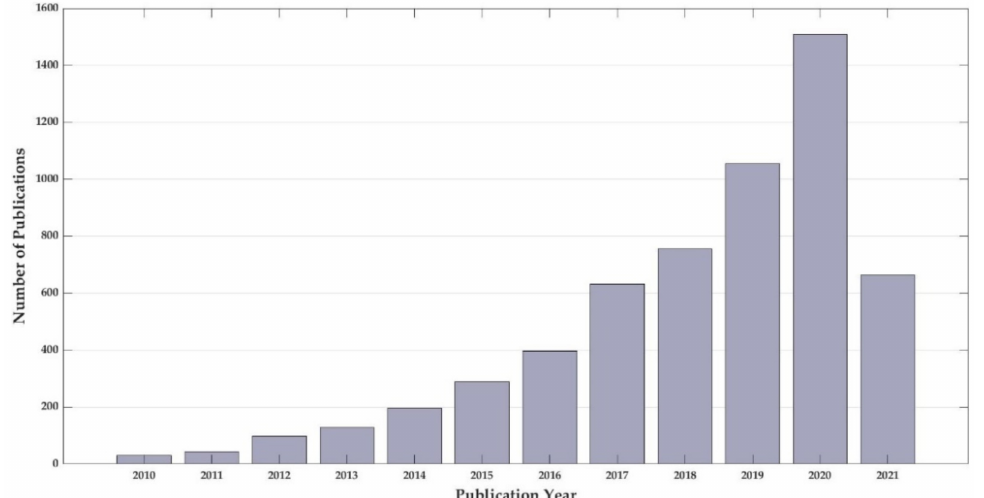
Figure 1. Number of publications that include the term “deep eutectic solvent” in their title since 2010. Source: Web of Science, 12 June 2021